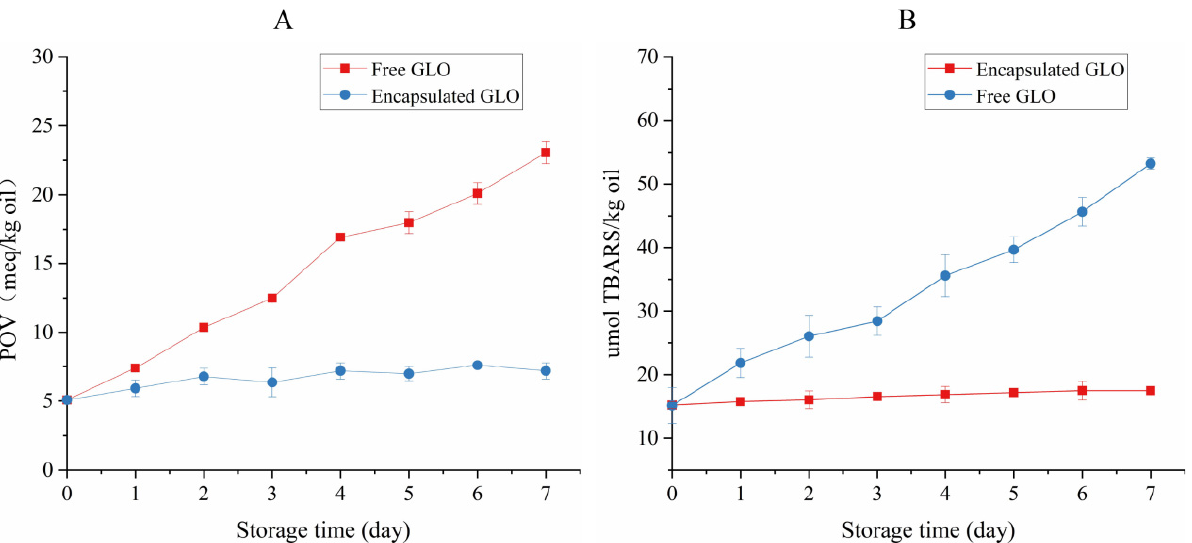
Figure 5. Peroxide value (POV) ( A ) and TBARS value ( B ) of encapsulated GLO and free GLO at 60 ℃ for 7 days.